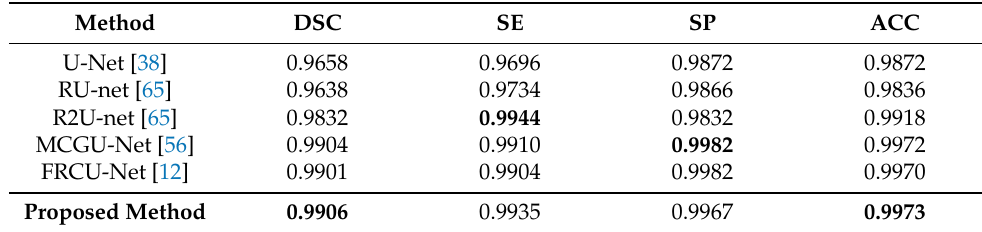
Table 4. Comparison results of the proposed method against the SOTA approaches on the lung dataset.